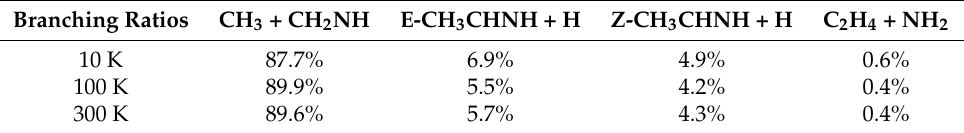
Table 3. Product branching ratios at various